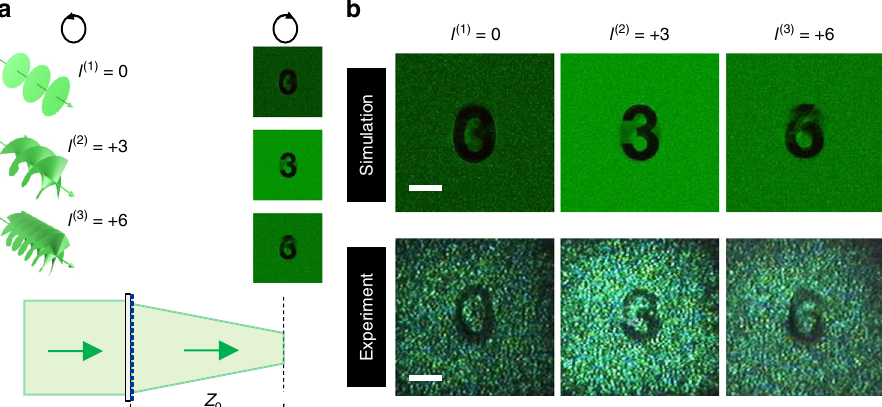
Fig. 3 OAM meta-transformer for the read-out of three OAM states. a Schematic of OAM meta-transformer designed on three OAM states. This meta- transformer is designed to reconstructed “ 0 ” , “ 3 ” and “ 6 ” patterns at l ( n ) = 0, 3, and 6, respectively. b Simulated (top) and measured (bottom) reconstructed patterns. Scale bar: 20 μ m